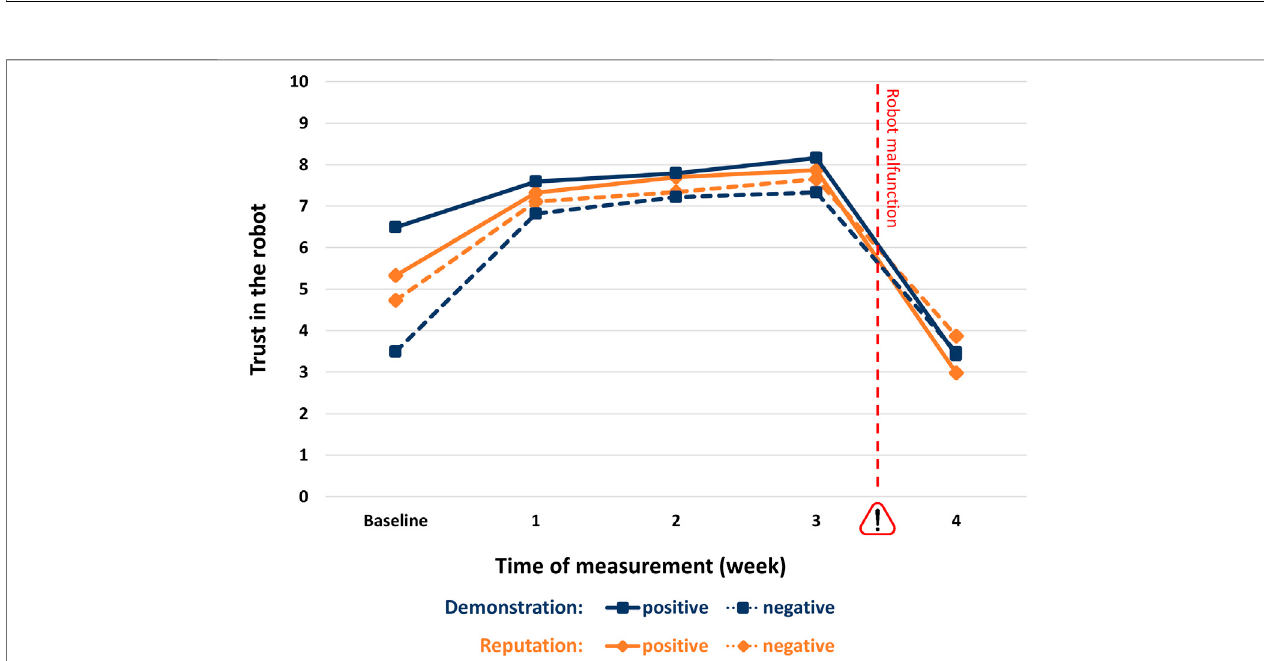
FIGURE 5 | Trust ratings (range: 0 – 10) for positive and negative reputation and demonstration